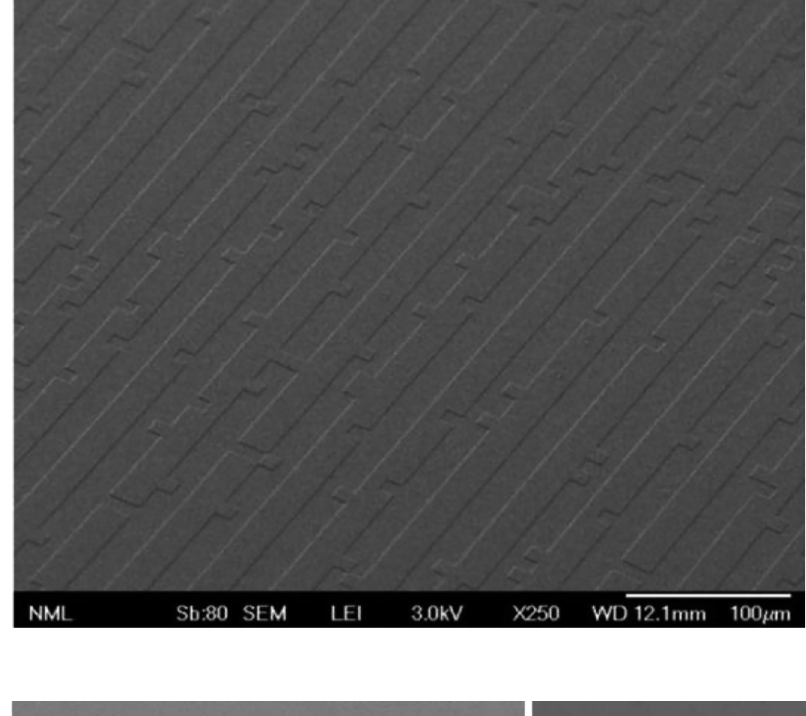
Figure 4: A DOE made by UV-NIL lithography of the MAPTMS : ZPO 8 : 2 composite.